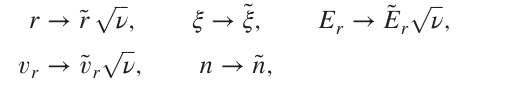
FIG. 2. Electron trajectories in scaled variables r= showing a bubble after the point driver.